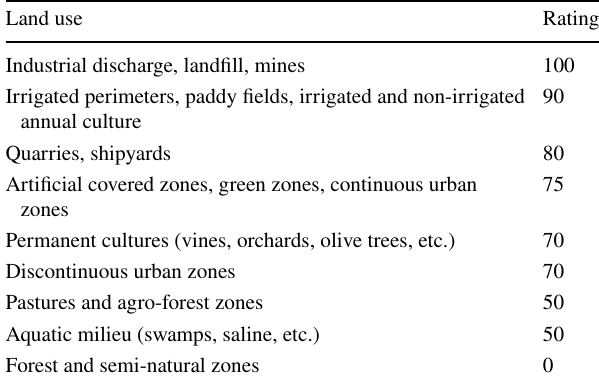
Table 10 Ratings for land use parameter according to SI method